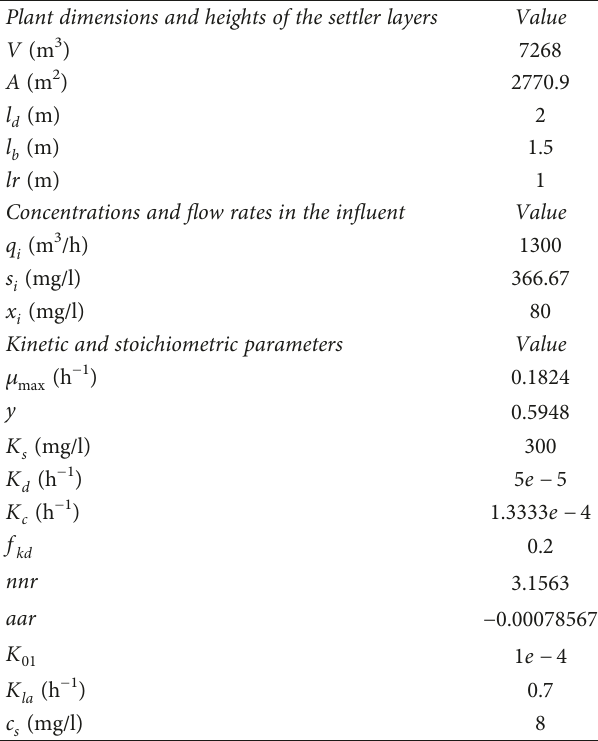
Table 12: Parameters of the Manresa WWTP. Plant dimensions and heights of the settler